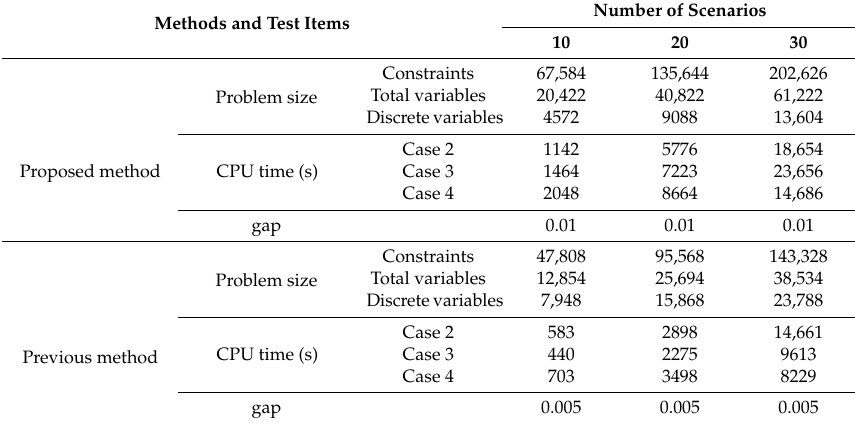
Table 4. Problem size and computing time of Cases 2–4 with different numbers of